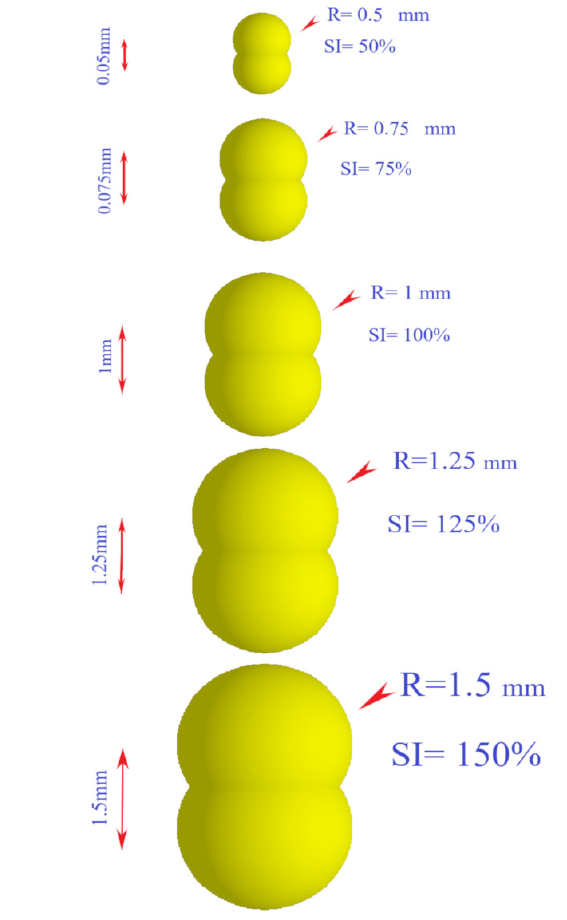
Figure 3. Various particle SI simulations(SI= 50%, 75%, 100%, 125%, 150% for all the particles respectively). 4.